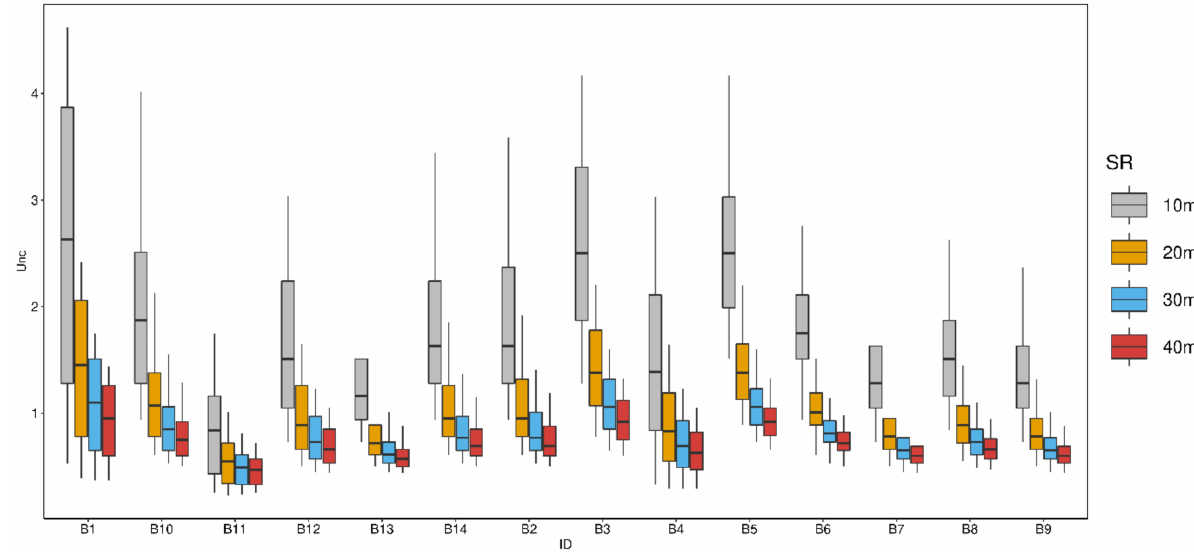
Figure 9. σ H ( x , y ) values distribution for forest biomes according to four operative